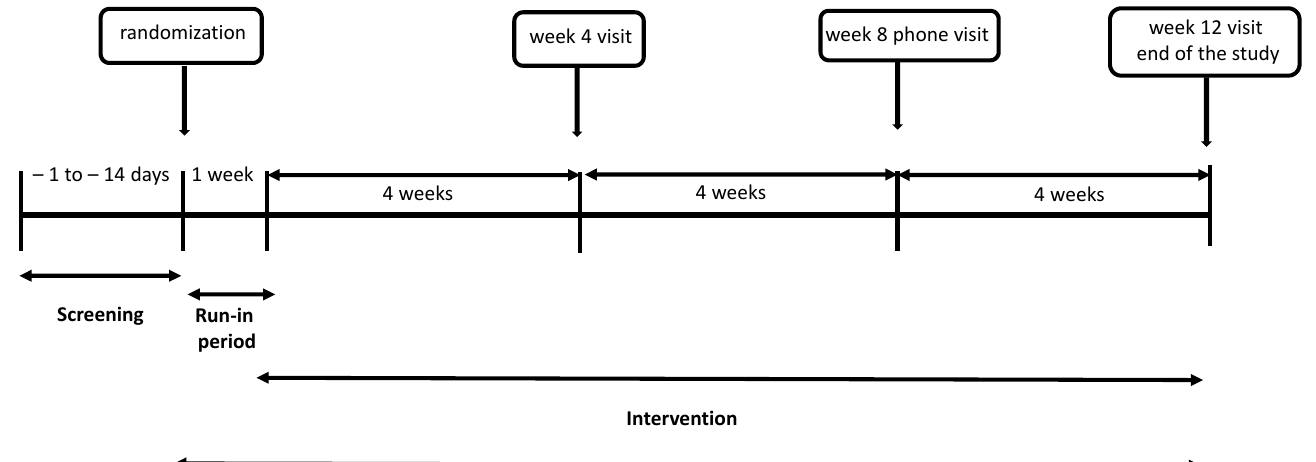
Figure 1. The study protocol